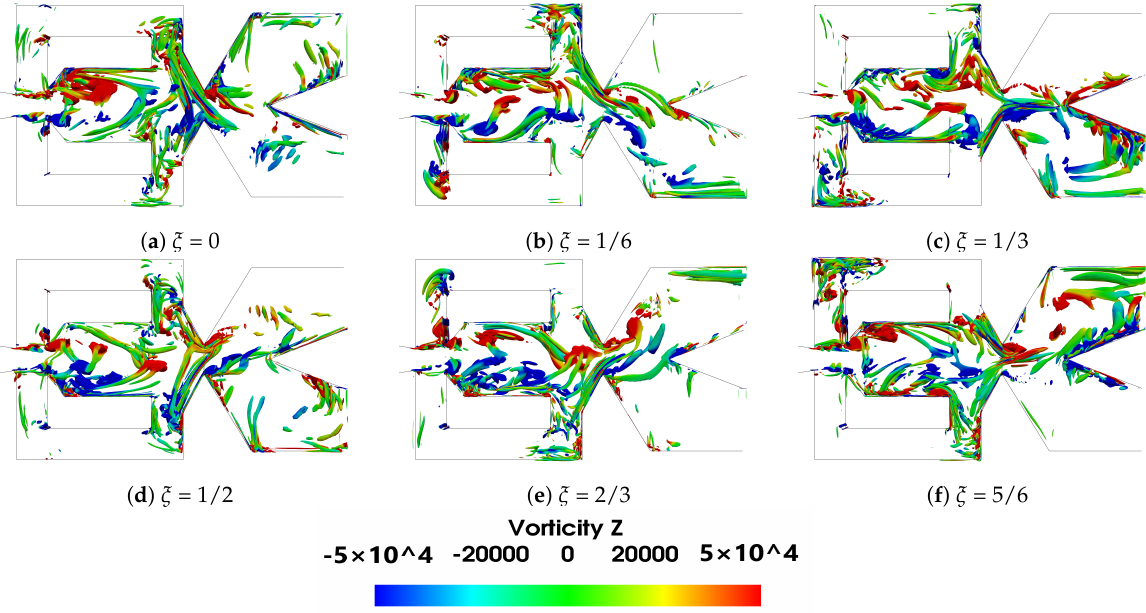
Figure 5. Q criterion representation at the mixing chamber period of oscillation divided into six equally spaced times, power nozzle velocity 97 m/s. Q = 11 × 10 8 . Baseline